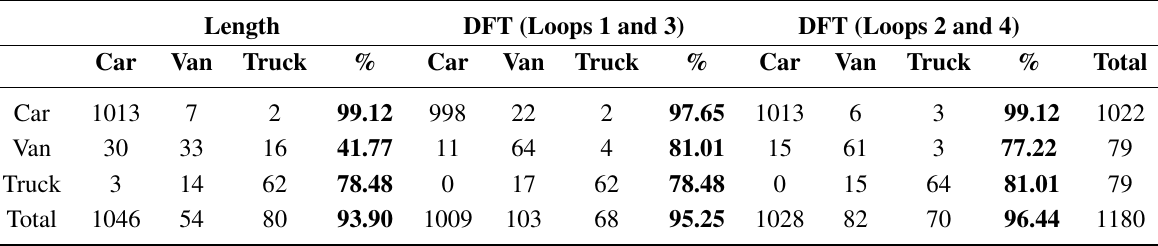
Table 2. Confusion matrices for AC-415 road.